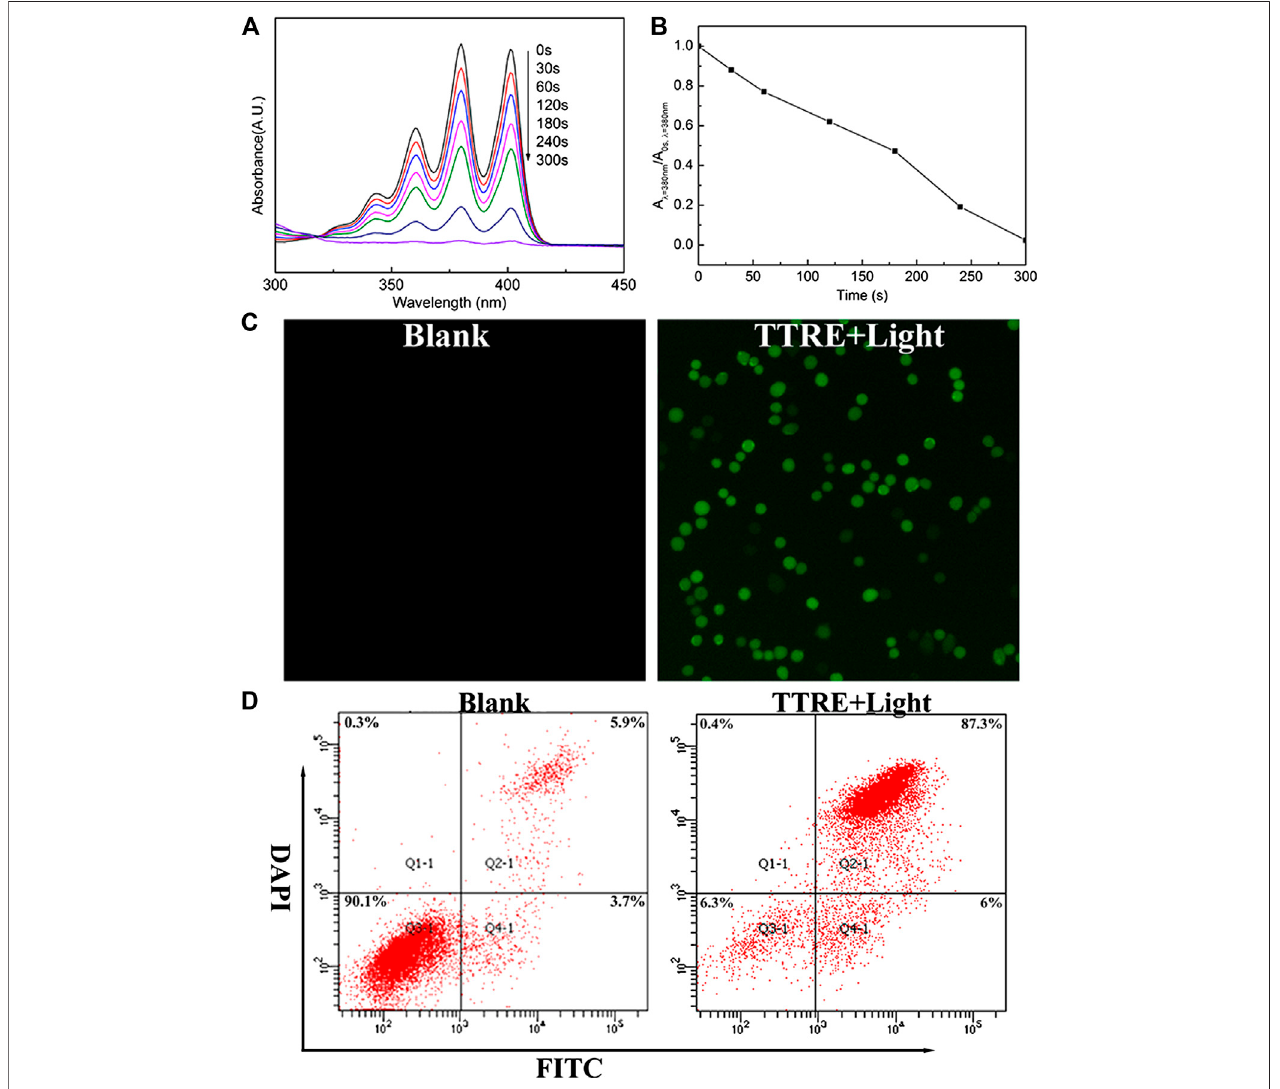
FIGURE 2 | (A) UV-vis spectra change of ABDA and TTRE with different irradiation time of white light (60 mW/cm 2 ). (B) Plots of A / A 0 at 378 nm of ABDA vs. different irradiation times. A 0 is the absorption of ABDA without irradiation, and A is the absorption with various irradiation time. (C) Intracellular ROS detection using DCFDA in 4T1 cells incubated with TTRE after white light irradiation. (D) Representative FCM pro fi les of 4T1 cells with different